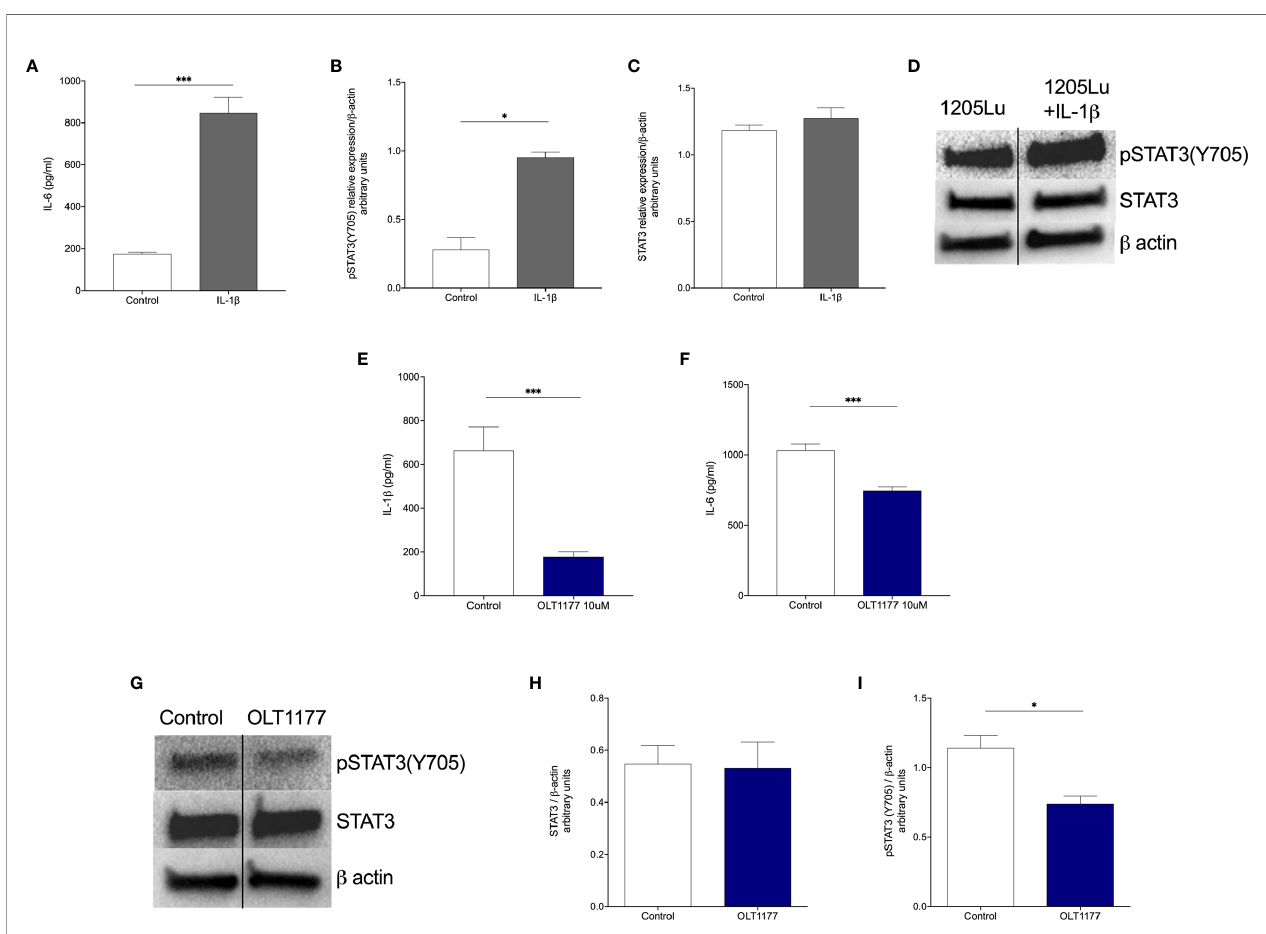
FIGURE 1 | Interkeukin-1 b induces pSTAT3(Y705) in human melanoma cells. (A) Mean ± SEM of IL-6 production from 1205Lu cells stimulated with IL-1 b after 24 hours (N=3). (B) Mean ± SEM of STAT3/ b -actin ratio for 1205Lu cells shown in (A) (N=3). (C) Mean ± SEM of pSTAT3(Y705)/ b -actin ratio for 1205Lu cells shown in (A) (N=3). (D) Representative western blot images from (B, C) . (E) Mean ± SEM of IL-1 b production from unstimulated 1205Lu cells treated with OLT1177 after 48 hours (N=3). (F) Mean ± SEM of IL-6 production from unstimulated 1205Lu cells treated with OLT1177 after 48 hours (N=3). (G) Representative western blot images from (H, I) . (H) Mean ± SEM of STAT3/ b -actin ratio for 1205Lu cells shown in (G) (N=3). (I) Mean ± SEM of pSTAT3(Y705)/ b -actin ratio for 1205Lu cells shown in (G) (N=3). * p < 0.05, *** p <